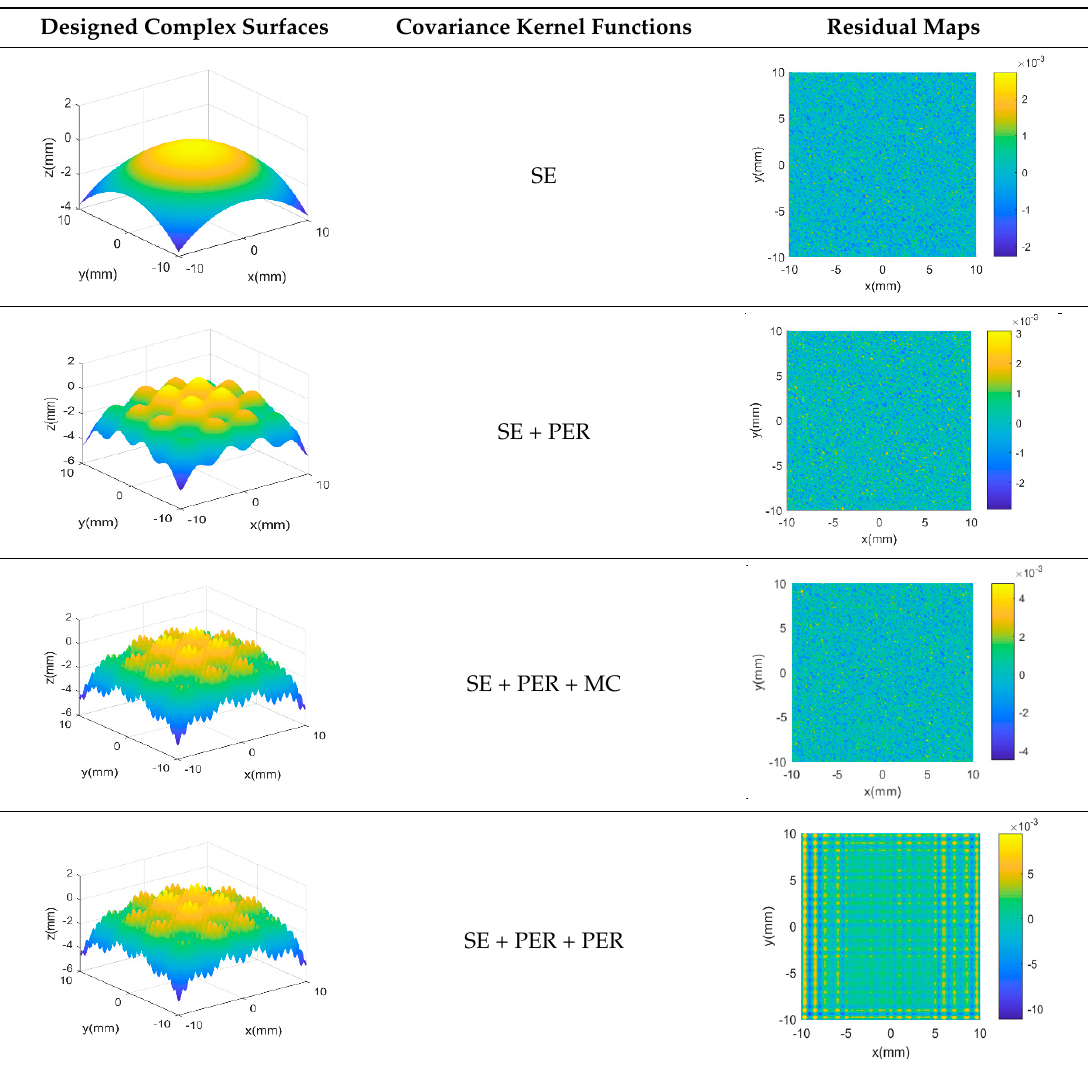
Table 2. GP modelling of various complex surfaces. T able 2 GP modelling of various complex